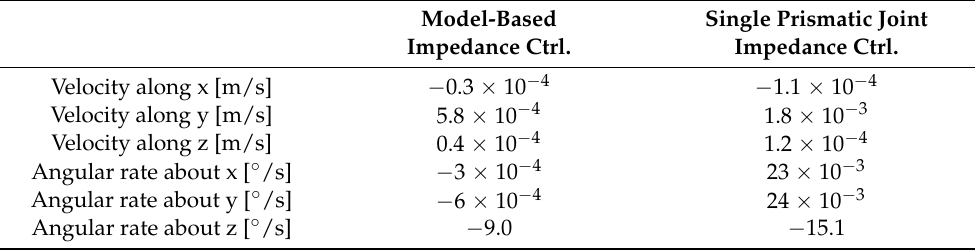
Model-Based Single Prismatic Joint Impedance Ctrl. Impedance Ctrl.